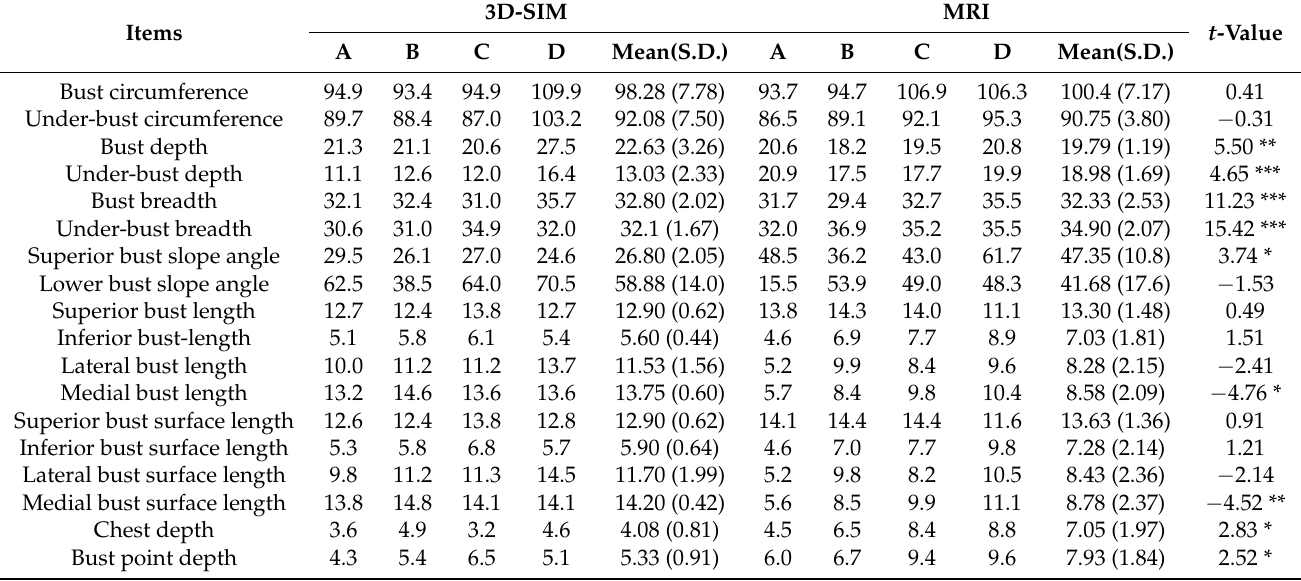
Table 7. Comparison of human body measurement data of participants (unit: